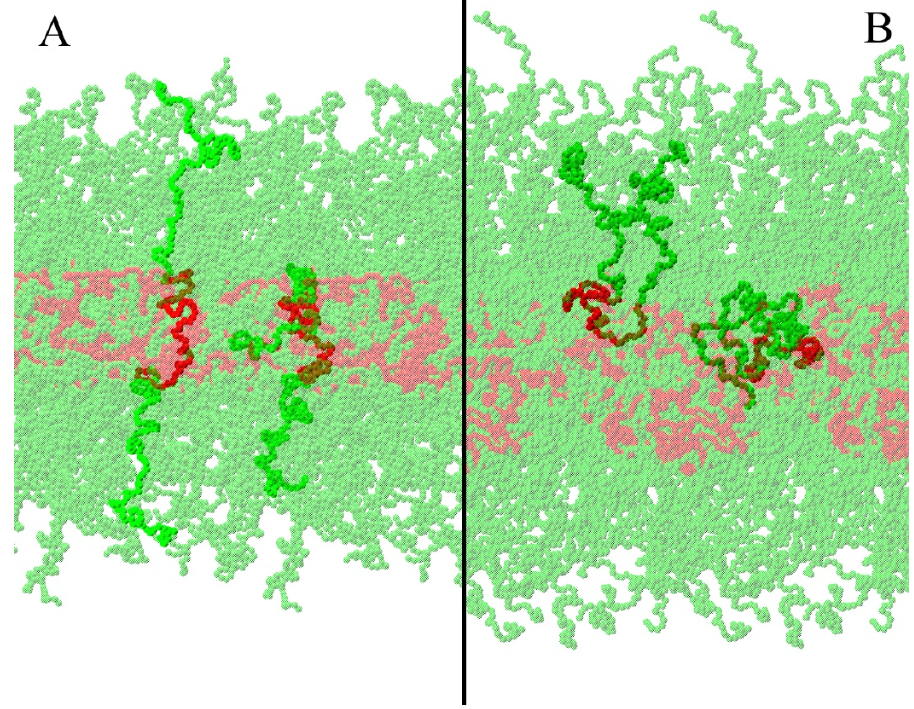
Figure 7. Snapshot of the LS ( A ) and LU ( B ) cases at the end of the simulation. For each snapshot, two individual polymers are highlighted, one representative of the S ( A ) or U ( B ) polymer configuration, and the other with a complex amorphous structure, where PEO beads are part of the lamellar-like core.